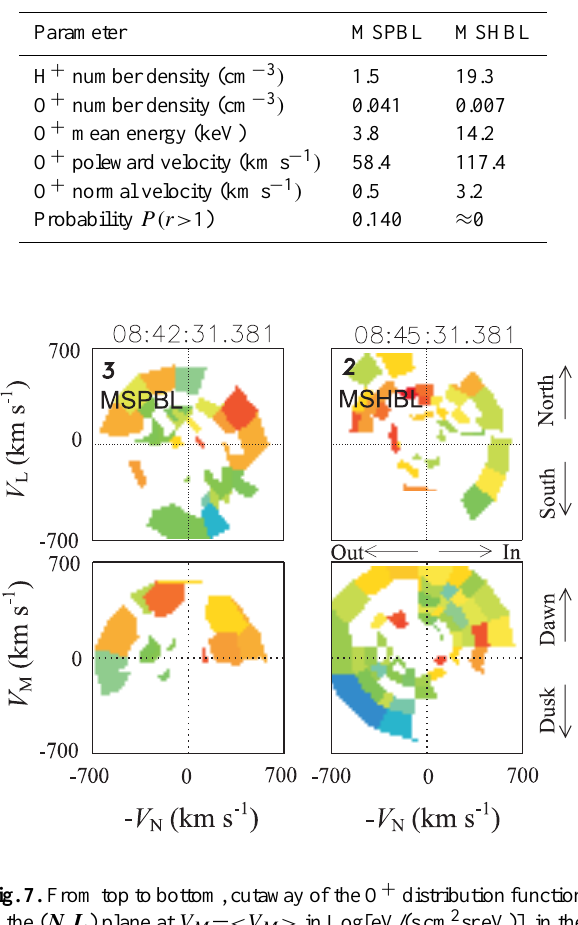
Table 1. List of mean parameters in the MSPBL and MSHBL in- ferred from the probability density functions of Fig. 10.